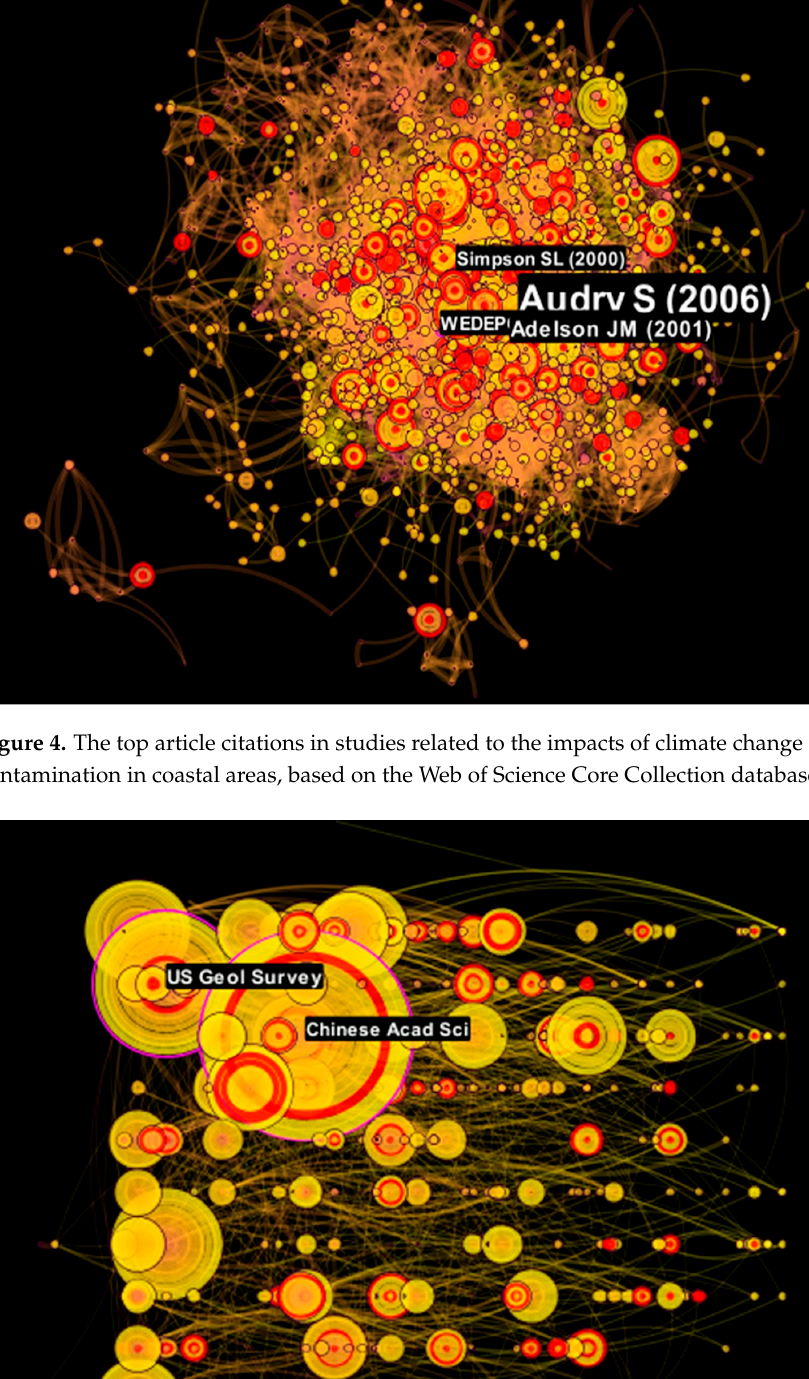
Figure 6. The most cited countries in studies related to the impacts of climate change on heavy metal contamination in coastal areas, based on the Web of Science Core Collection database (1979–2021). The top 10 most cited journals are shown in Figure 7. Ecology, Geochimica et Cos- mochimica Acta and Science of the Total Environment were the top three most cited jour- nals in studies related to climate change and heavy metals in coastal areas, with centrality scores of 0.18, 0.16 and 0.15, respectively. Ecology is a journal that reports research on all aspects of ecology, while Geochimica et Cosmochimica Acta publishes research on the subjects of terrestrial geochemistry, meteoritics and planetary geochemistry. Science of the Total Environment publishes research on the environment as a total, including the